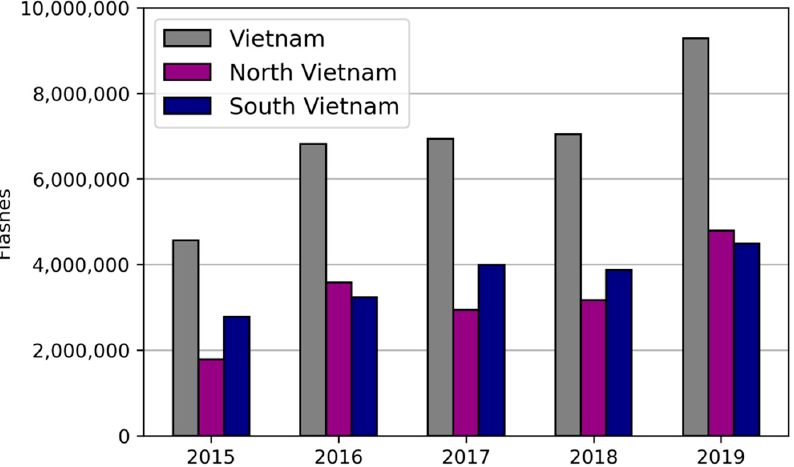
Figure 2. Annual number of lightning flashes in the whole of Vietnam, North Vietnam, and South Vietnam in 2015–2019. Vietnam in